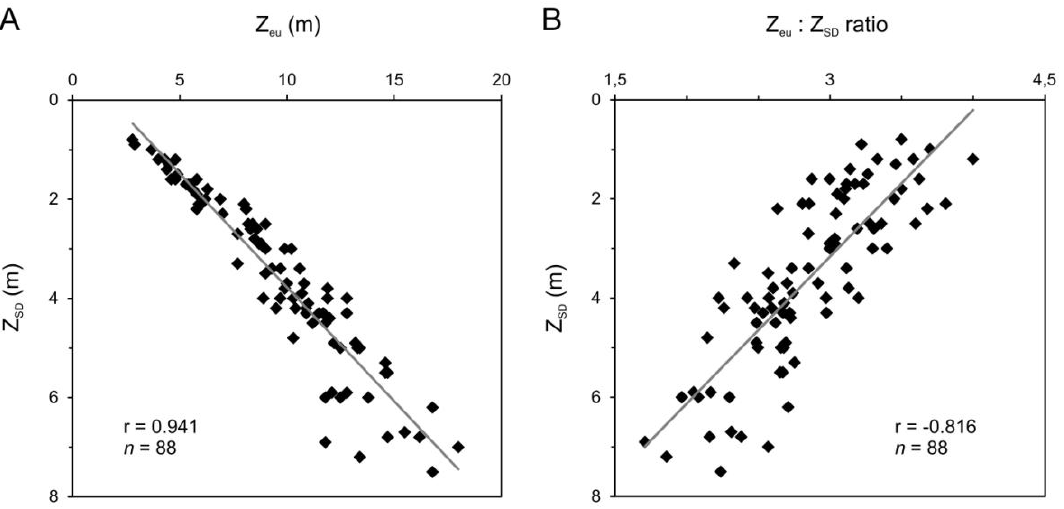
Figure 2. Correlation (Pearson) between ( A ) Secchi depth ( Z and ( B ) Secchi depth and the ratio of these two. The depths are measured values of the original dataset.